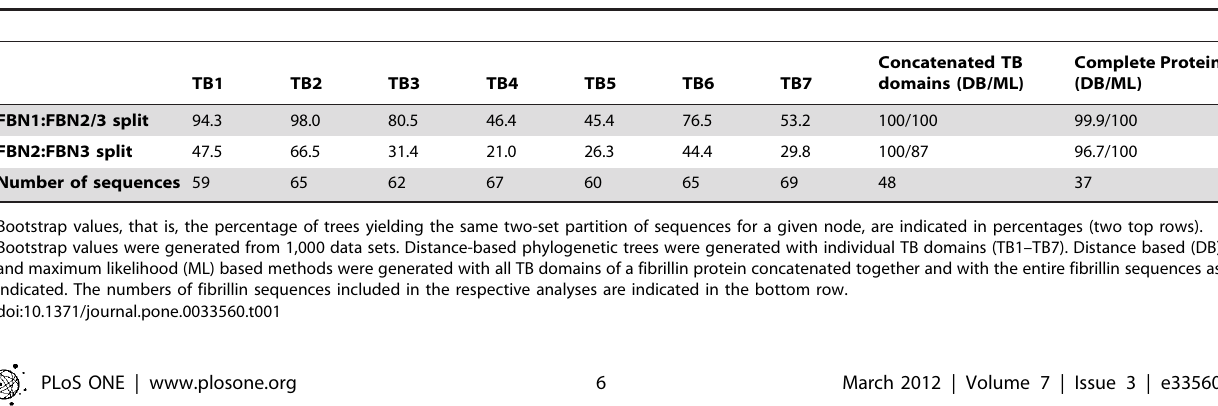
duplications to yield three present-day fibrillins from one ancestral fibrillin.